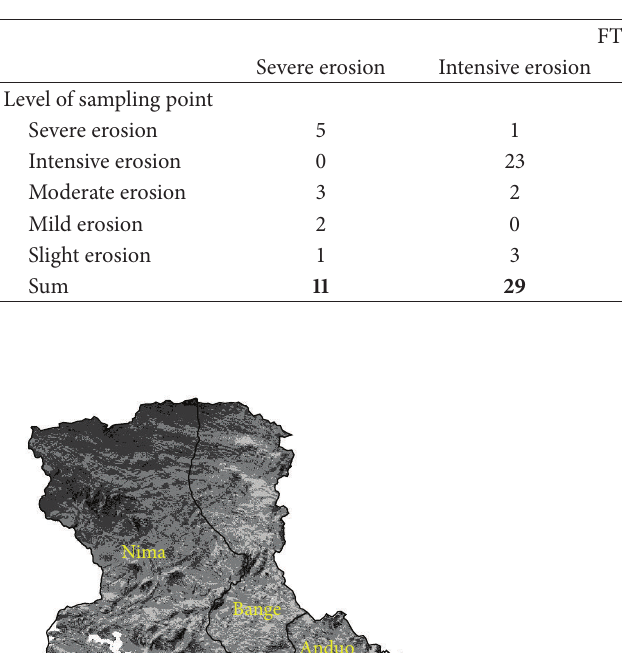
Table 2: Error matrix of the quantity of FT erosion.